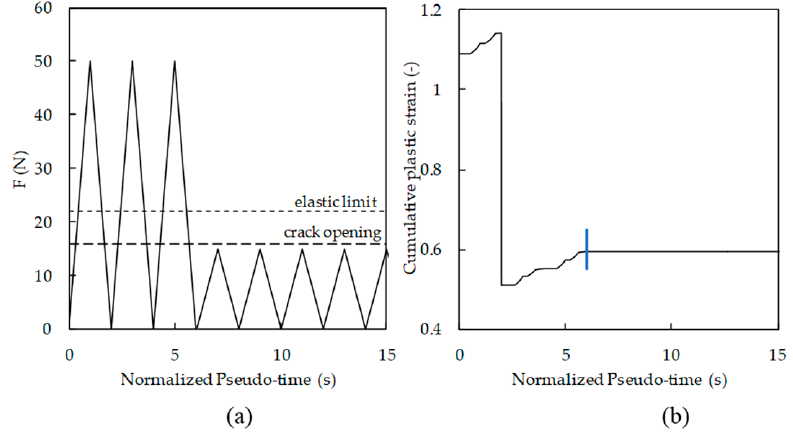
Figure 10. Effect of high–low load sequence ( a ) Spectrum of the applied load. ( b ) Evolution of the cumulative plastic strain at the crack tip.